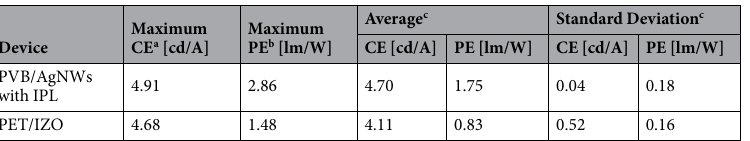
Table 4. Device characteristics of OLEDs on PVB/AgNWs with IPL electrodes fabricated in this study and PET/IZO. a Maximum CE: maximum current efficiency. b Maximum PE: maximum power efficiency. c Current density from 25 mA/cm 2 to 150 mA/cm 2